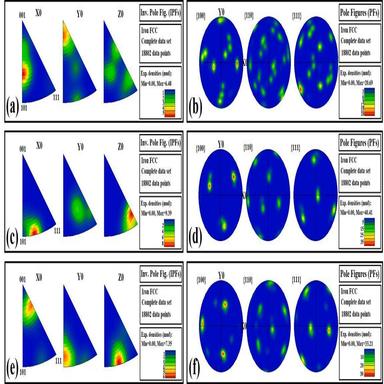
(a, c, e) The inverse (IPF) and (b, d, f) pole-figure (PF) plots showing the crystallographic textural maps obtained by EBSD analysis demonstrating the preferred orientations for (a, b) X-, (c, d) Y-, and (e, f) Z-sections of consolidated nanocomposite cubic structure.